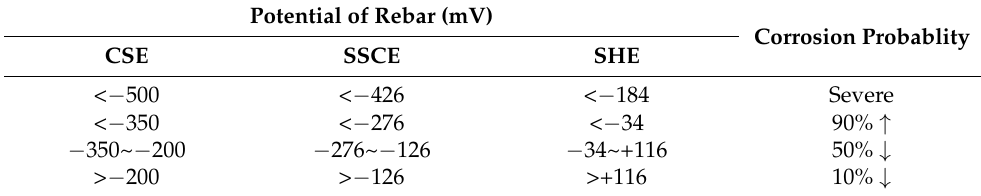
Table 5. ASTM C 876 criteria for corrosion.